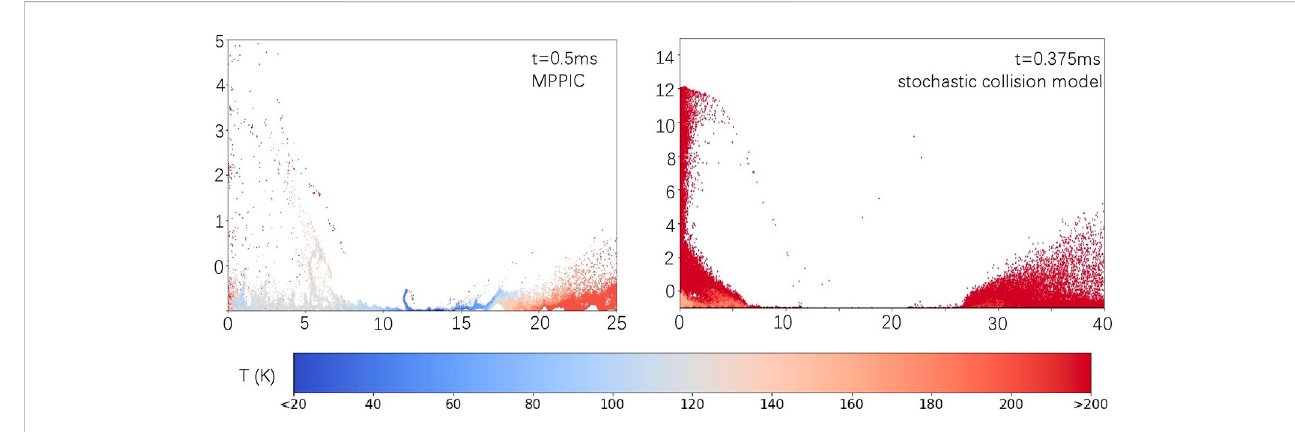
FIGURE 22 Examples of particle temperature distributions using the stochastic collision model (right) and the MPPIC method